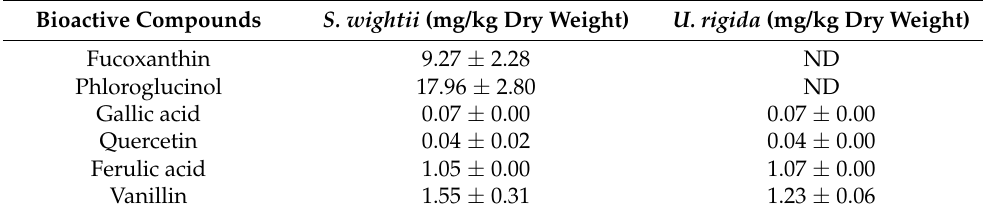
Table 4. Quantification of bioactive compounds of edible macroalgaes S. wightii and U. rigida using